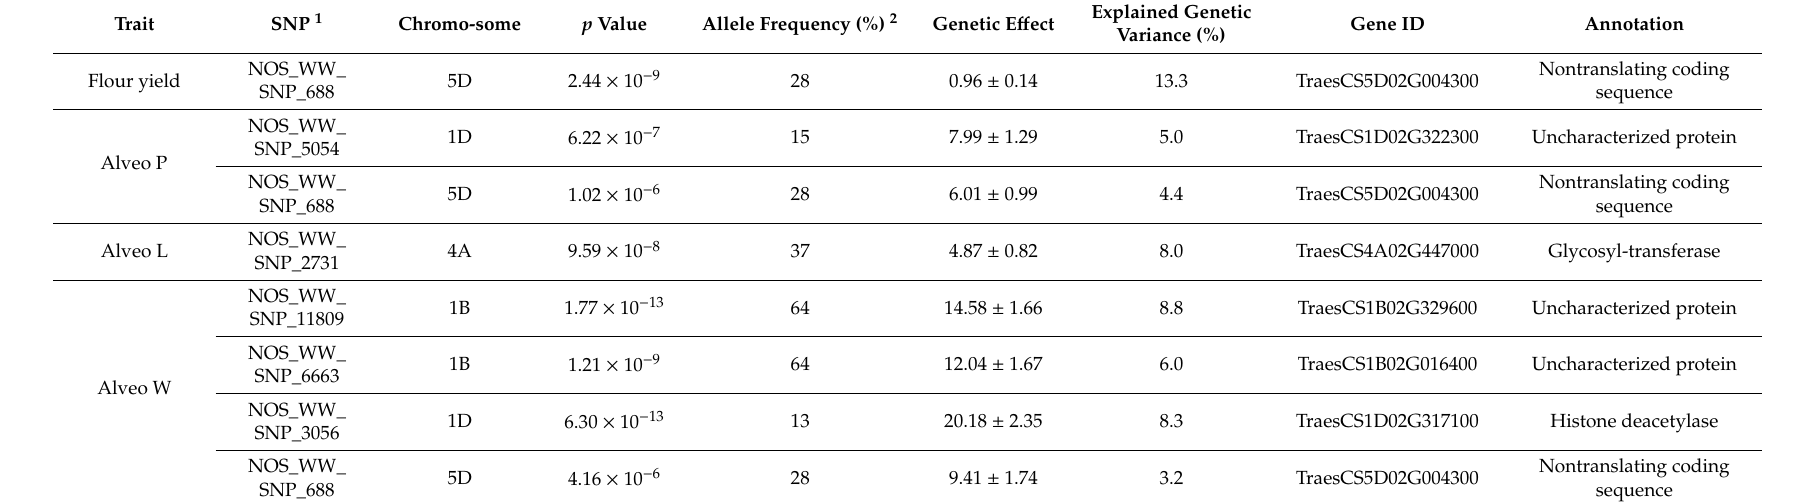
Table 3. SNPs significantly associated with each of the quality traits based on single marker